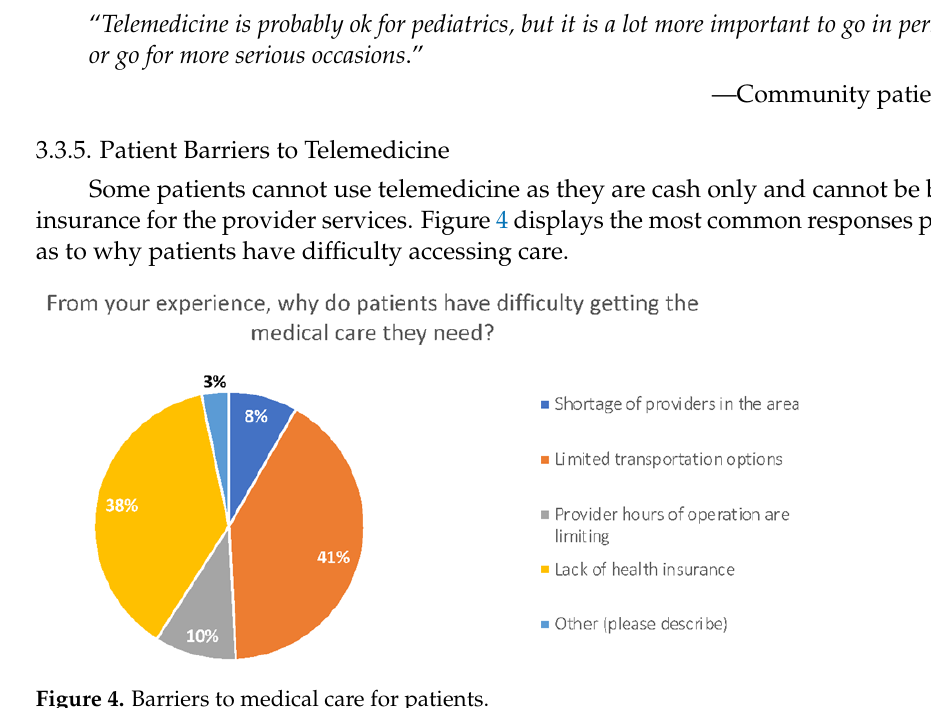
Figure 4. Barriers to medical care for patients.